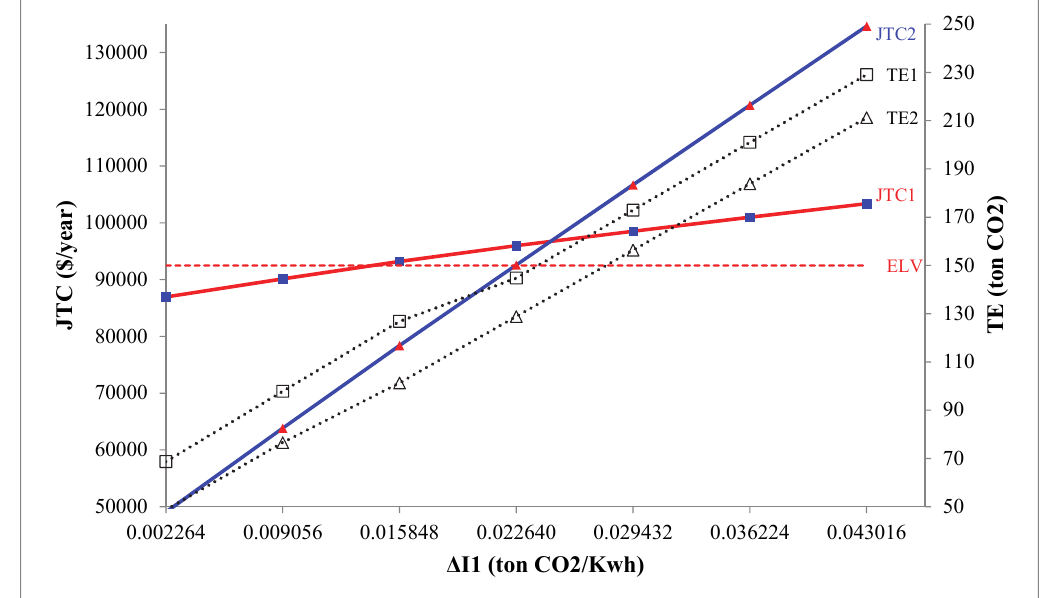
Fig. 16. Effect of changing in loss rate of electricity, steam, heating and cooling on total cost and total emission